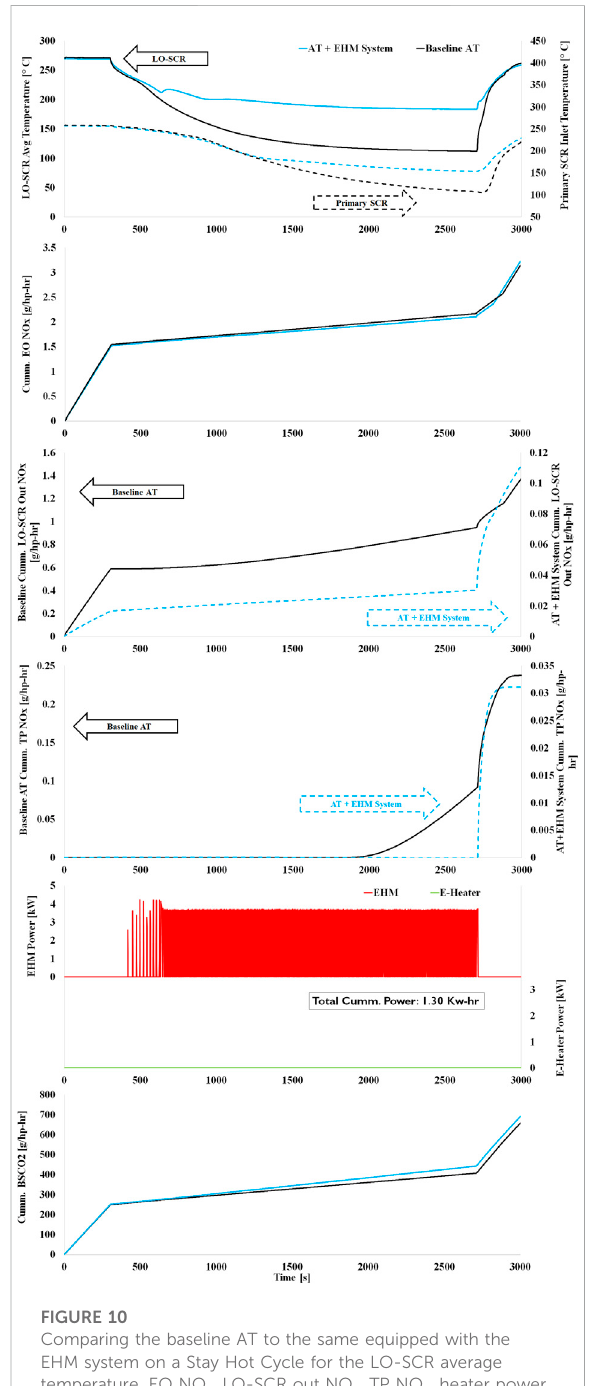
TABLE 10 Cold WHTC test